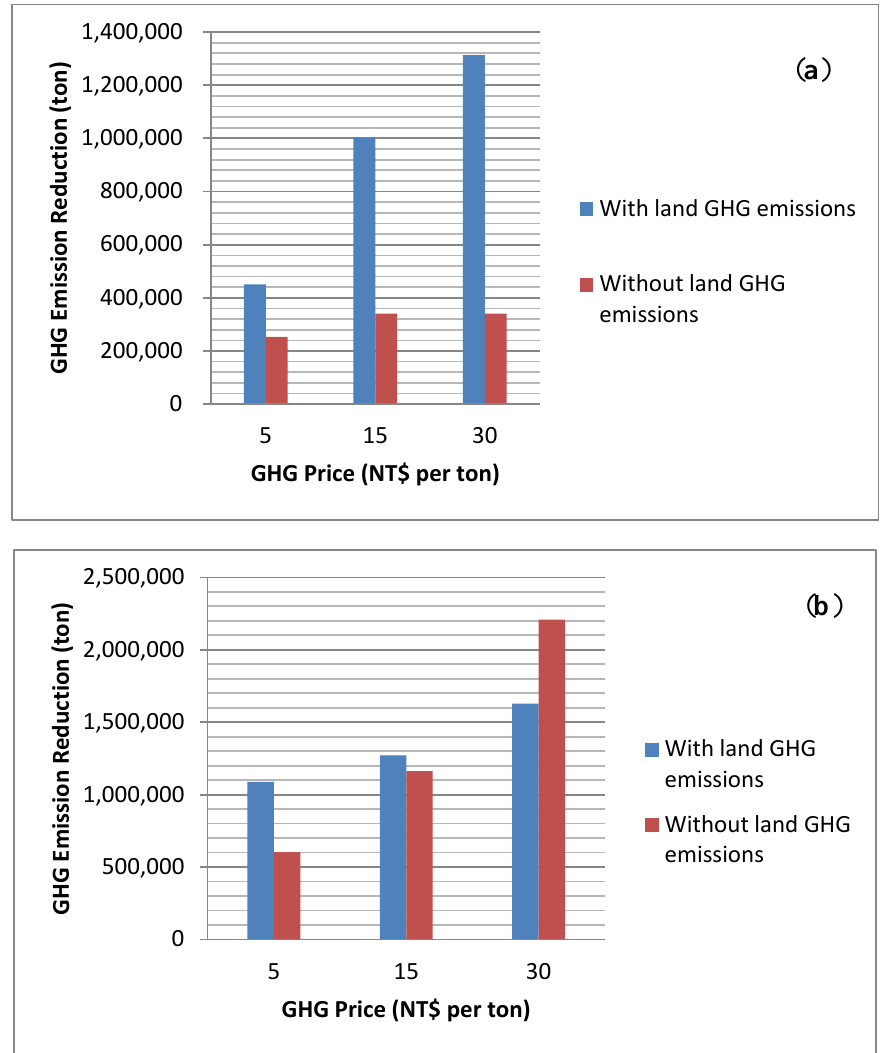
Figure 3. ( a ) Net GHG emissions offset when biochar is burned for energy; ( b ) Net GHG emissions offset when biochar is used as a soil